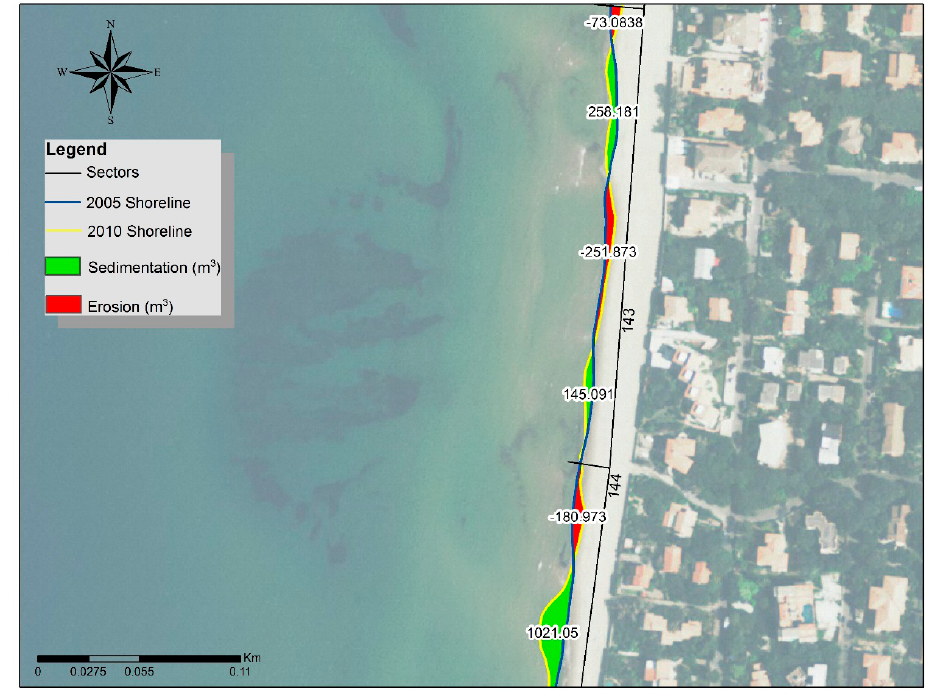
Figure 7. Shoreline comparison and extraction of aerial variation in the timeframe 2005–2010 for sector 144: Polygon extraction and aerial calculation of the erosion / sedimentation quantities are shown as positive or negative values.